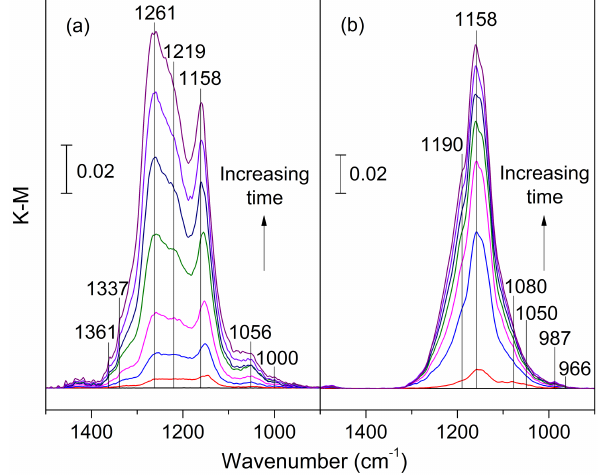
Figure 1. DRIFT spectra of different samples recorded upon expo-